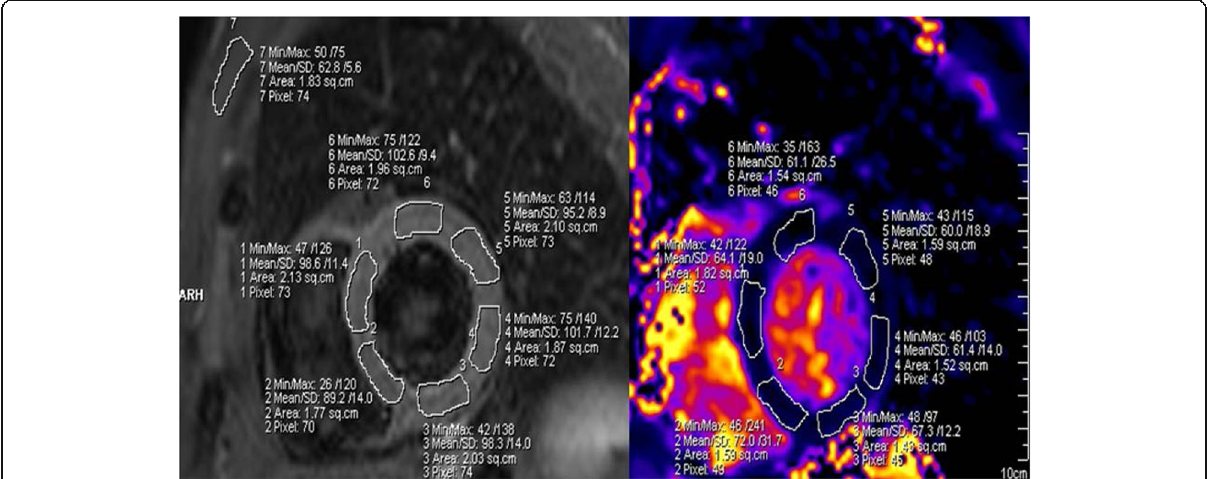
Fig. 3 Short axis view at mid ventricular level in a patient with multi vessel disease. a The routine myocardial edema sequence TIRM was confusing in detection of the myocardial edema due to multi-territory affection. b Represents the T2 mapping delineating the myocardial